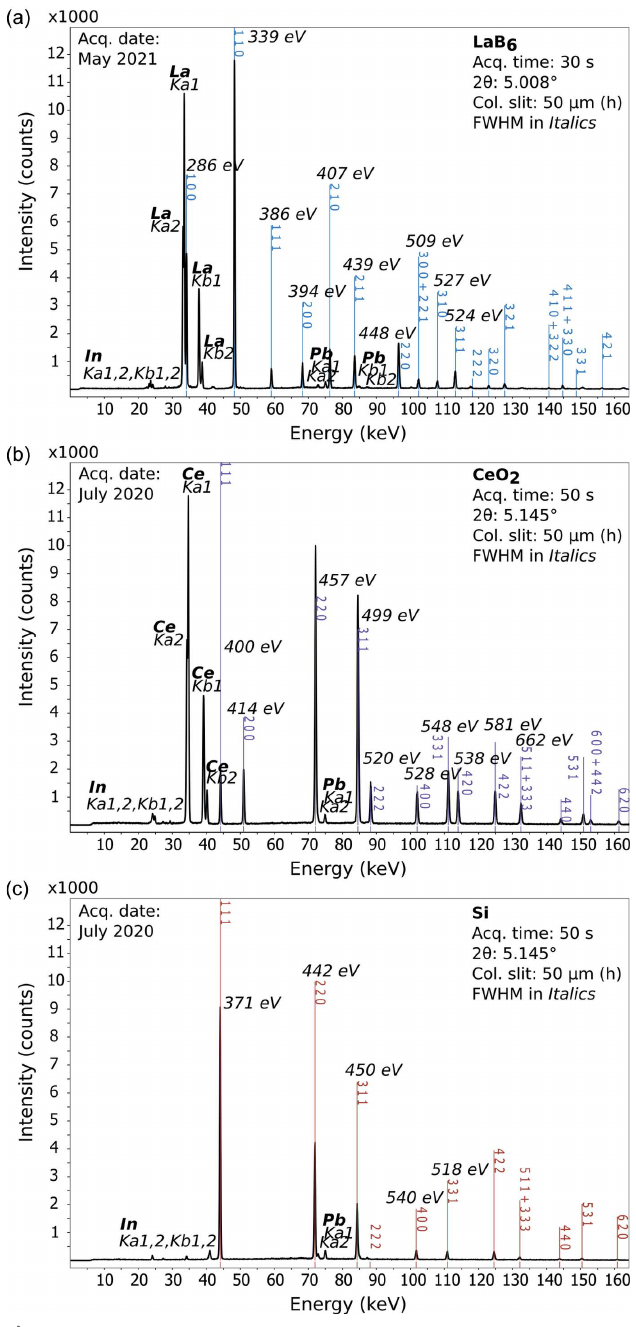
Figure 9 Diffraction patterns obtained from NIST standards: ( a ) LaB 6 , ( b ) CeO 2 and ( c ) Si. The conditions (acquisition time, detector position, collimator slit gap) are indicated for all patterns. Peak fitting (symmetric pseudo Voigt) and FWHM calculations were carried out using the software PDIndexer (Seto et al. ,